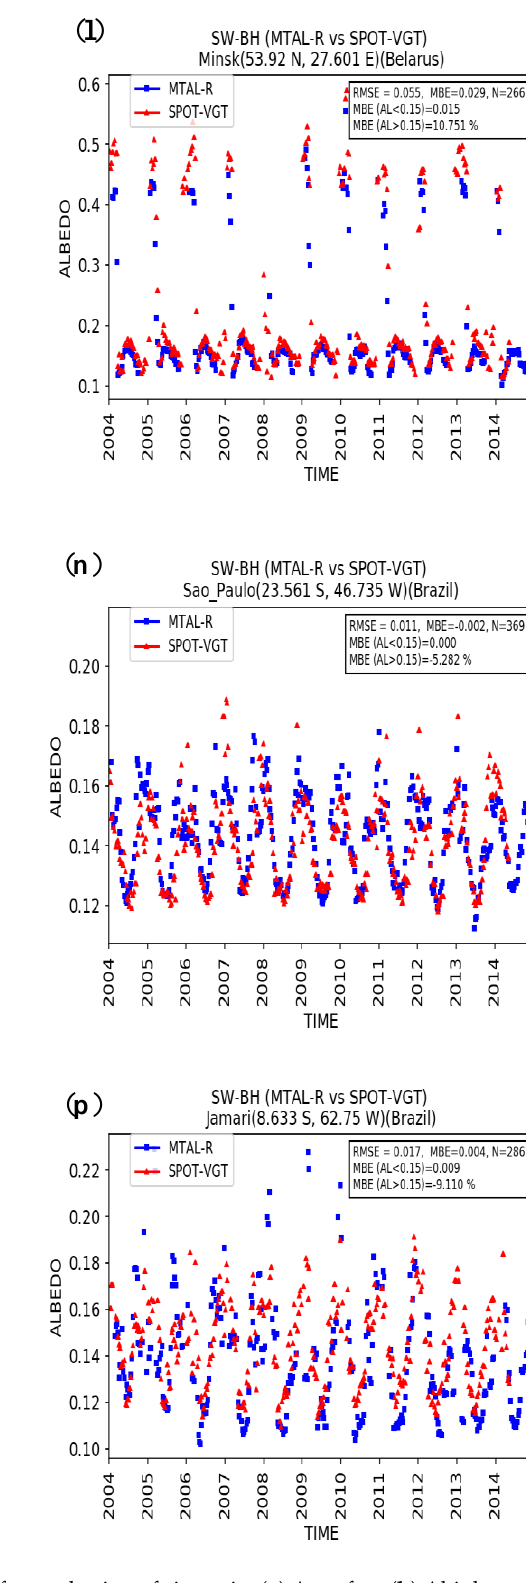
Figure 4. Time series of MTAL-R versus SPOT-VGT for a selection of sites, viz: ( a ) Agoufou; ( b ) Ahi de Cara; ( c ) Armilla; ( d ) IASBS; ( e ) IER_Cinzana; ( f ) Saada; ( g ) Abisko; ( h ) Martova; ( i ) Ispra; ( j ) Baneasa; ( k ) Moldova; ( l ) Minsk; ( m ) Dhadnah; ( n ) Sao-Paulo; ( o ) Potosi_mine and ( p ) Jamari, for the period between 2004 and 2014.